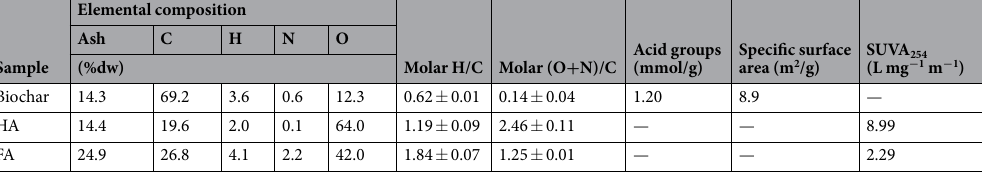
Table 1. Characteristics of biochar and DOM.